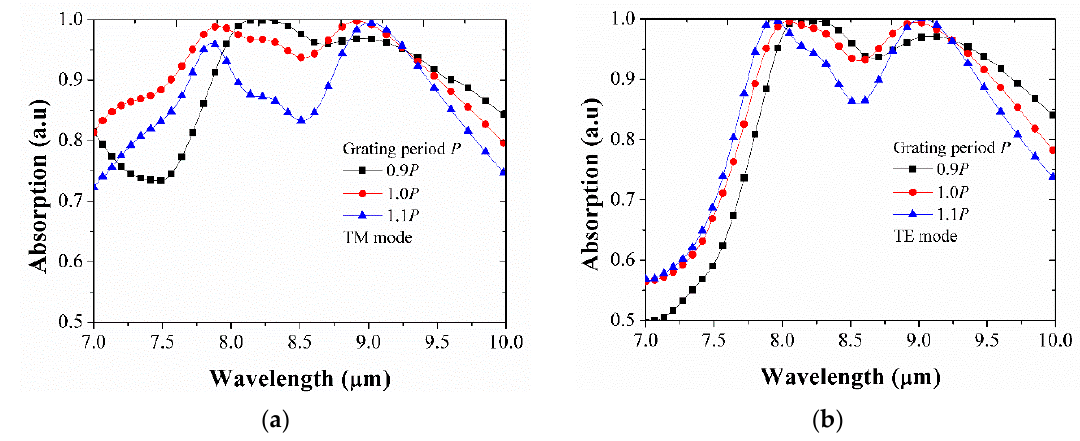
Figure 6. Investigation of the effect of periodicity P for absorption light in the structure. ( a ) for TM mode, ( b ) for TE mode.